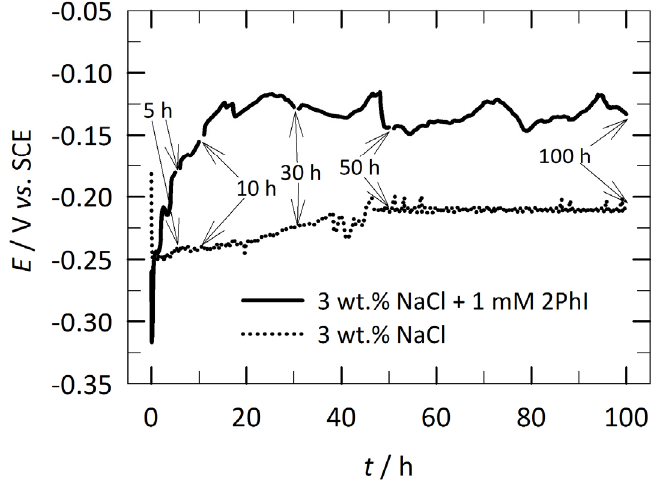
Figure 4. Chronopotentiometry curve measurements for copper samples immersed in 3 wt.% NaCl solution with and without addition of 1 mM 2PhI, at 25 °C. The times when the EIS measurements were performed (the discontinuous parts of the curve) are indicated by the arrows.